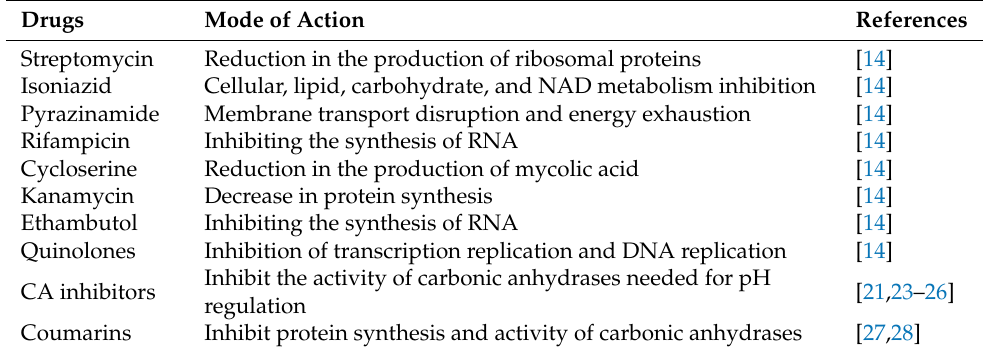
Table 1. Anti-TB drugs and their mechanism of